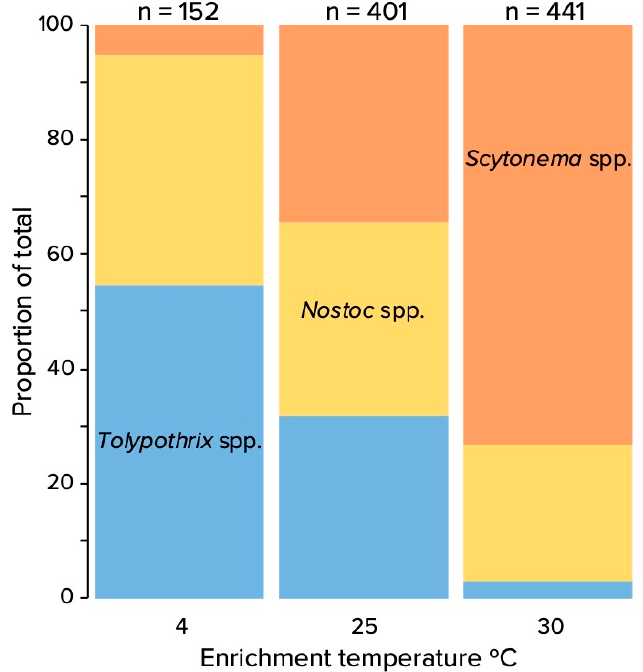
Figure 1. Relative proportion of colonies assignable to Scytonema spp., Nostoc spp., and Tolypothrix spp. in enriched cultures obtained on medium without combined nitrogen as a function of incubation